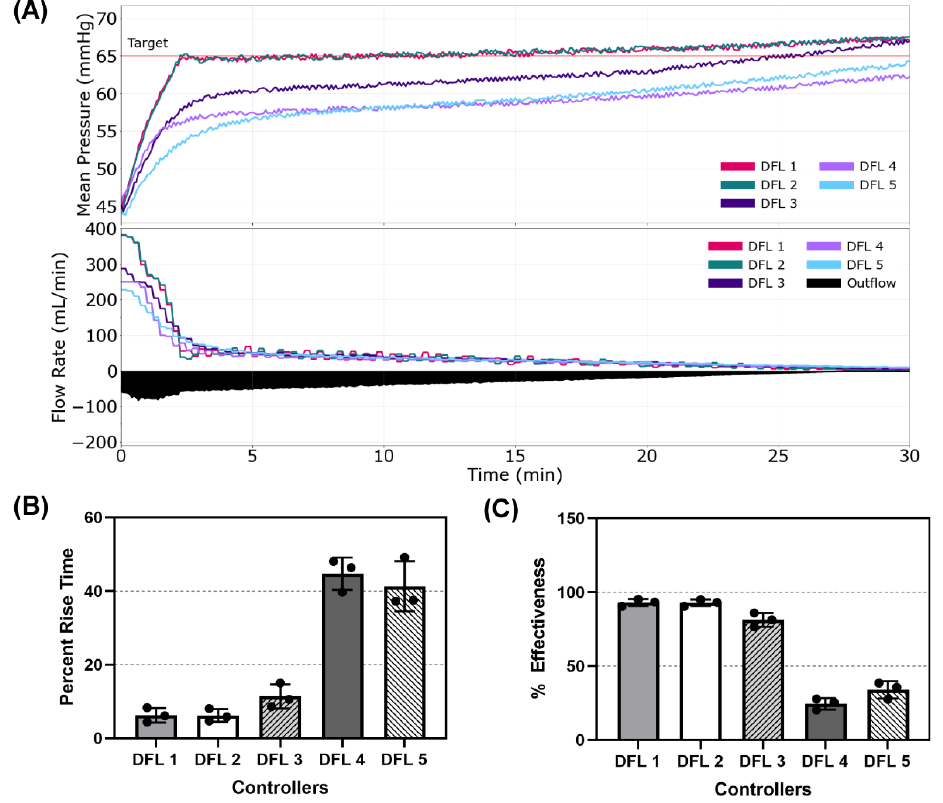
Figure 6. Dual-input fuzzy logic results for Scenario 3. Scenario 3 began with a MAP of 45 mmHg with an active hemorrhage slowing with time to mimic coagulation for 30 min, with a resuscitation target of 65 mmHg. ( A ) Five controller designs’ MAP and infusion rate vs. time are shown for one replicate run. A single representative outflow vs. time result is shown. ( B ) Percent rise time and ( C ) effectiveness performance metrics for each controller design are shown as mean values from three subject variability runs, with error bars denoting standard deviation.